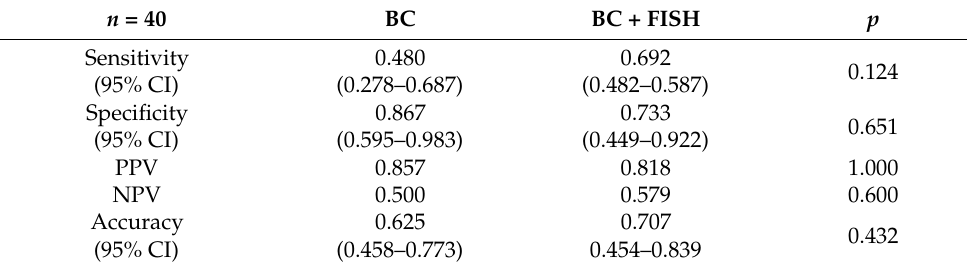
Table 4. Statistical performances of brush cytology (BC) vs. BC + FISH (intrinsic stenosis group). n = 40 BC BC + FISH p Sensitivity (95% CI)